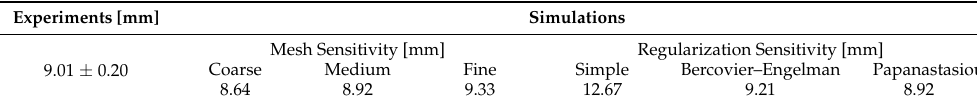
Figure 8. Sensitivity of the velocity distribution to the mesh refinement. Table 3. Summary of the boundary layer thickness sensitivities to the mesh refinement and the regularization model.